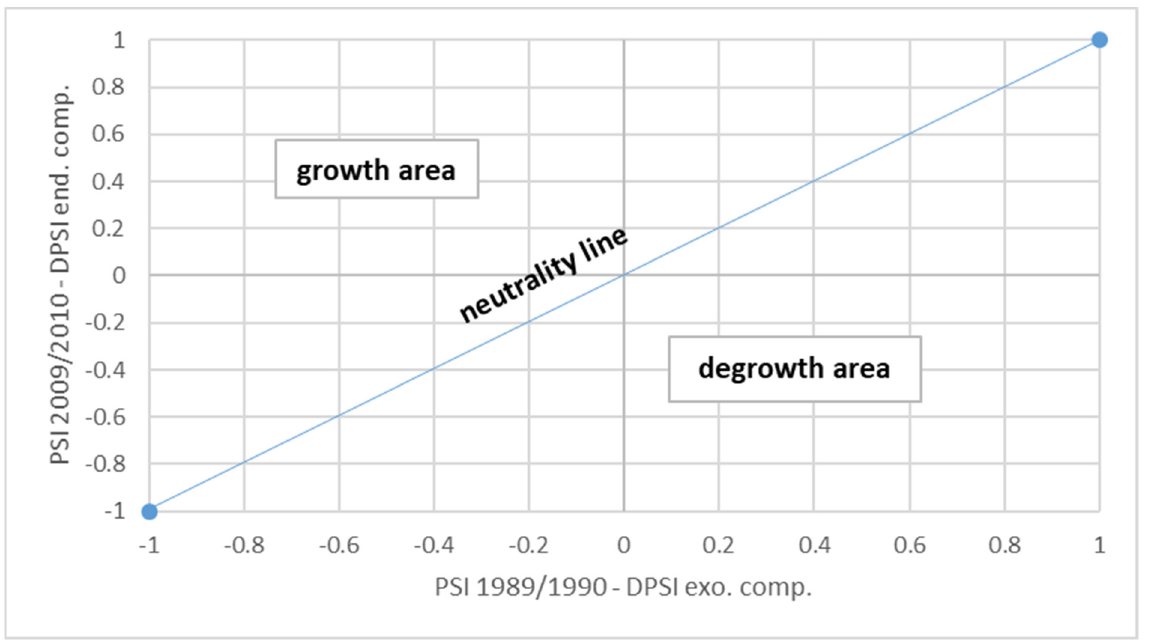
Figure 2. Cartesian representation of the endogenous and exogenous components of the PSI . The authors.